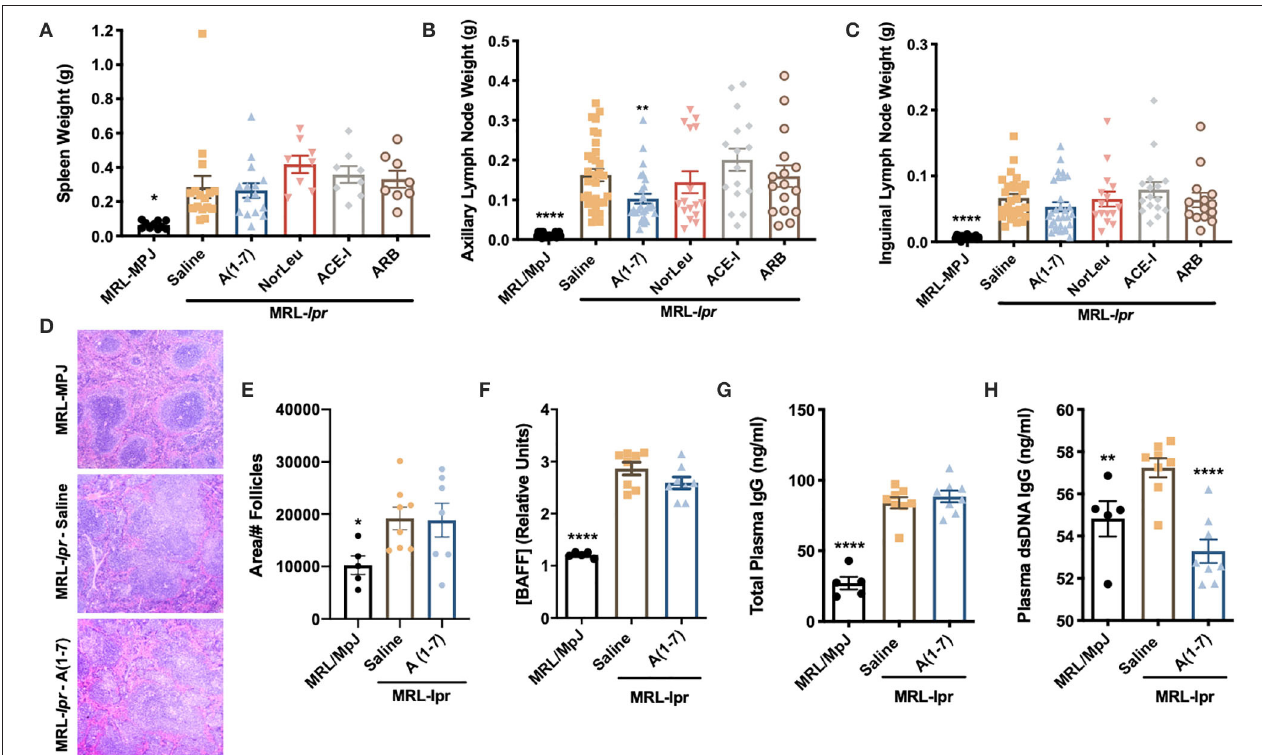
FIGURE 2 | A(1-7) treatment shows some improvement in reducing lymph node size and anti-dsDNA IgG antibodies. (A–C) The spleen and the auxiliary and inguinal lymph nodes were removed at necropsy and weighed. (D) Paraffin-embedded spleen samples were stained with H&E. The whole span of the spleen was photographed at x20 magnification. (E) Only follicles completely visible in the field where counted and measured. (F–H) The concentration of circulating BAFF, total plasma IgG, and anti-dsDNA IgG antibodies were measured from plasma collected at necropsy. Statistical analysis was done using Prism 8.4.0, t -tests were used to compare all groups to saline treated MRL -lpr mice; * p ≤ 0.05, ** p ≤ 0.01, **** p ≤